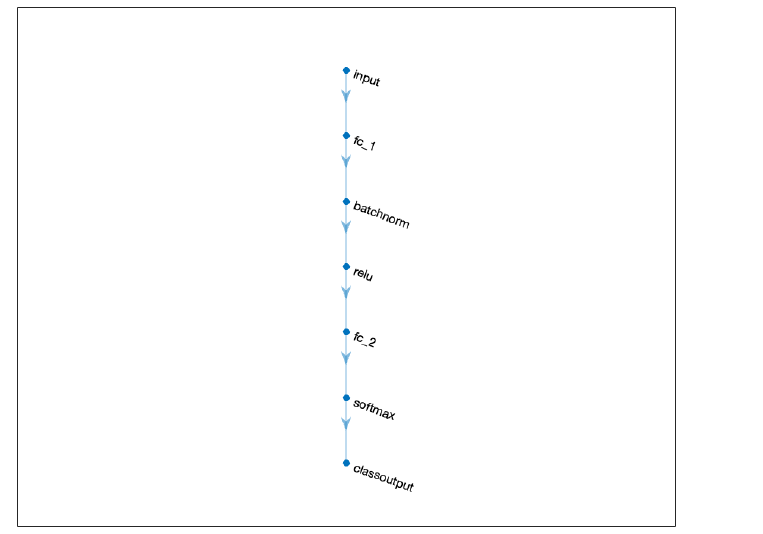
Figure 6. Architecture of the Neural